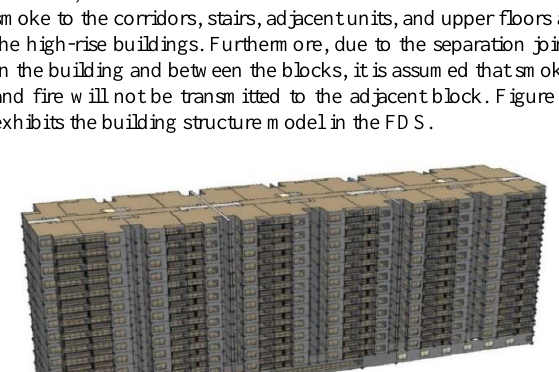
Figure 2. Case Study: a high-rise building in Tehran